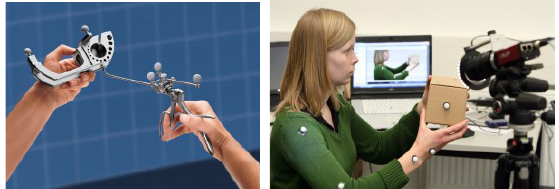
Figure 1: Example applications with spherical targets left: medical probing (Brainlab); right: motion tracking (IAPG)